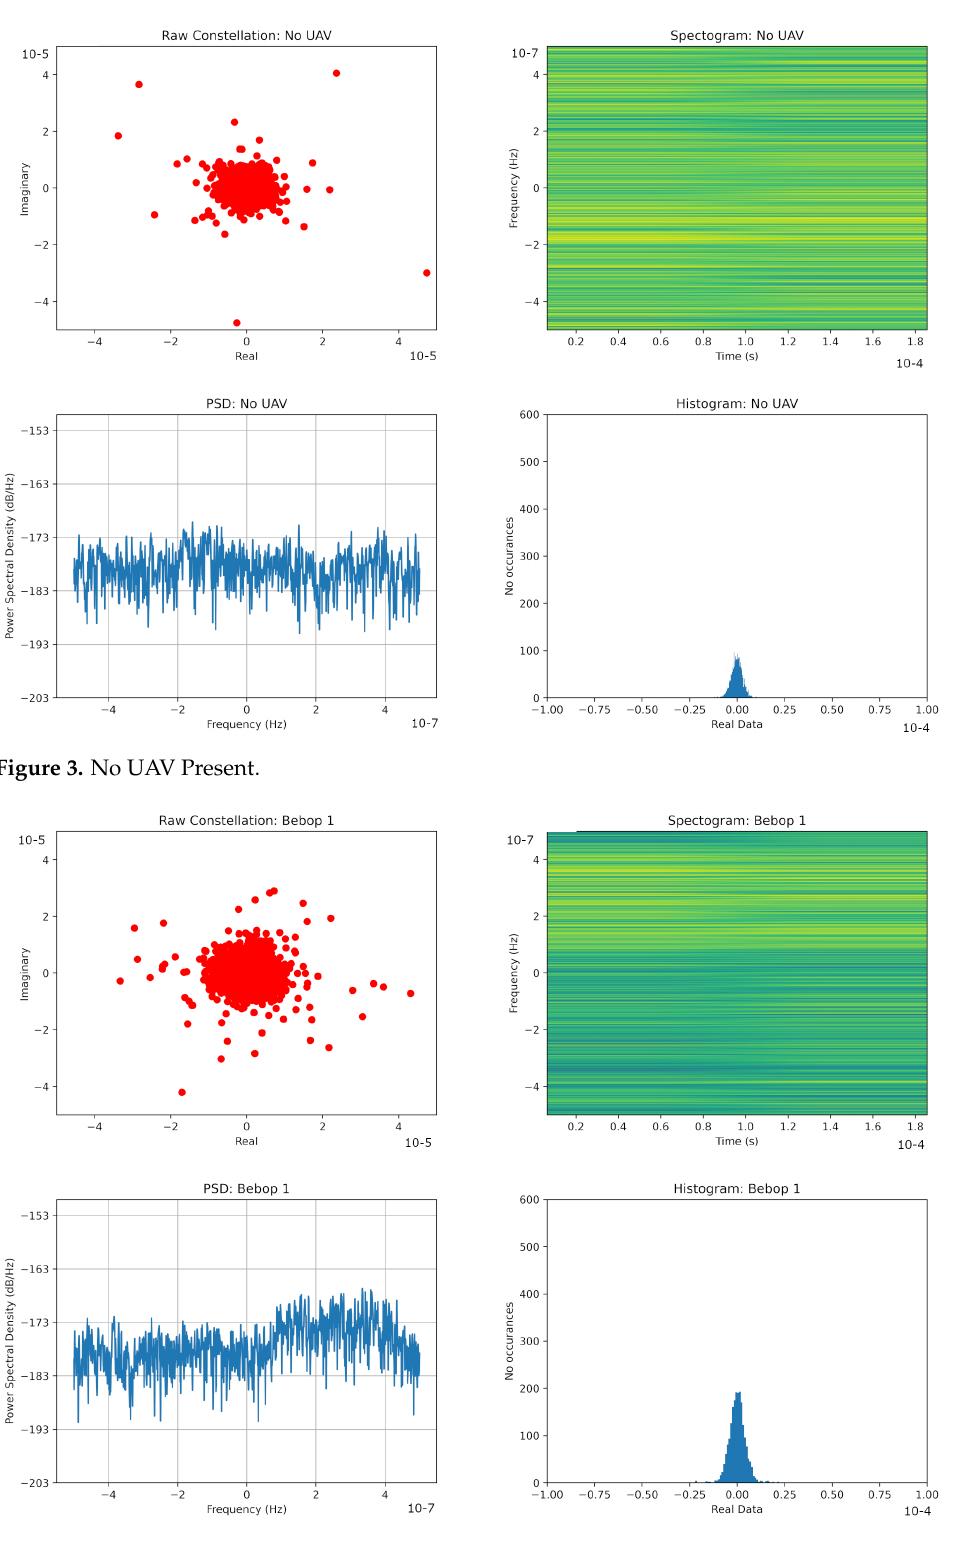
Figure 4. Bebop Mode 1—switched